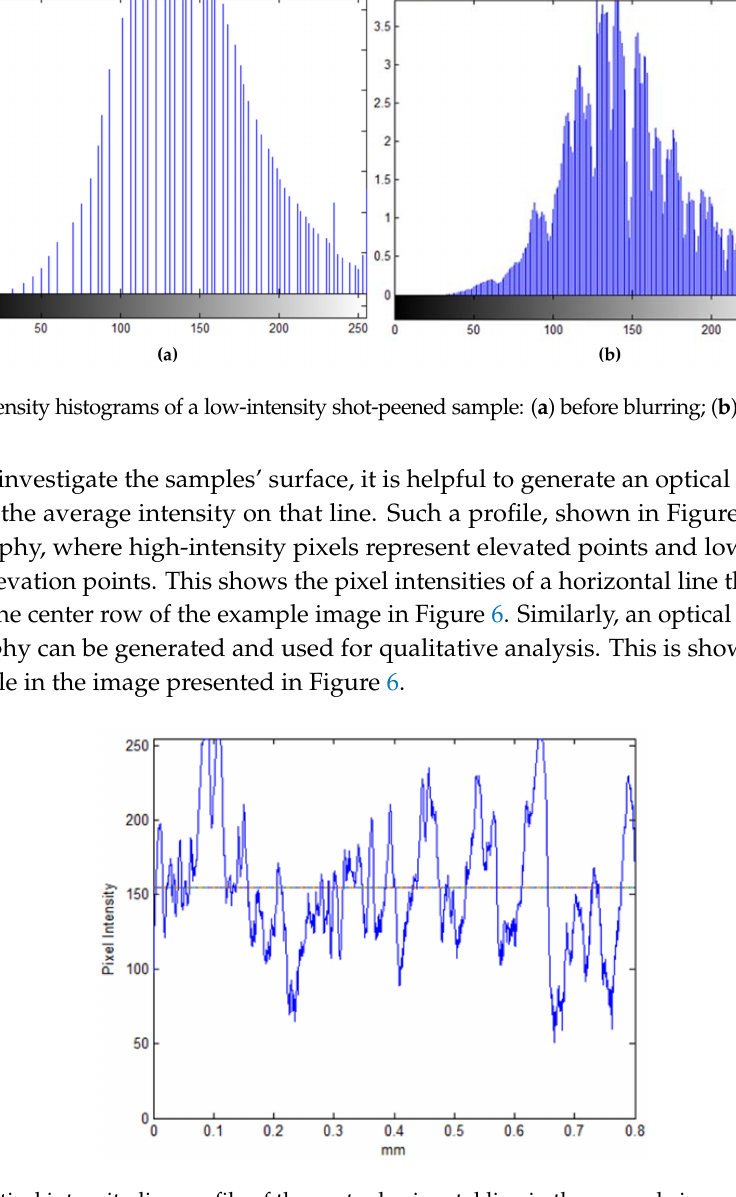
Figure 8. Optical intensity line profile of the center horizontal line in the example image. The average intensity level is depicted as a line.